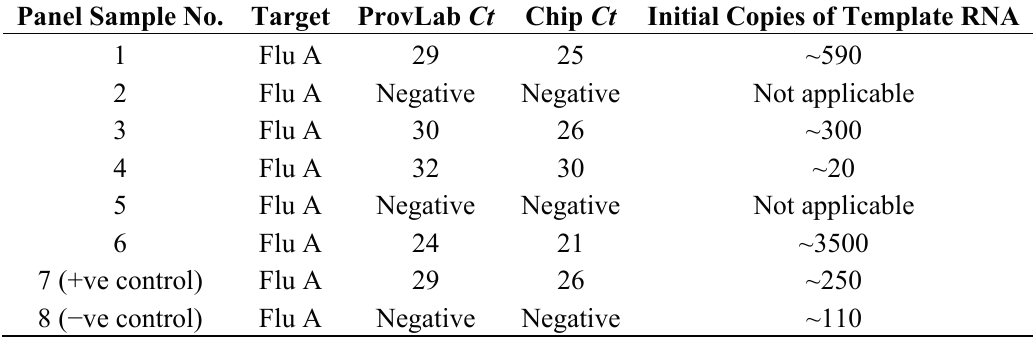
Table 3. Outcomes of the micro-device quantitative, reverse transcription, polymerase chain reaction (qRT-PCR micro-device) assay using panel samples of Table 1b. Panel Sample No. Target ProvLab Ct Chip Ct Initial Copies of Template